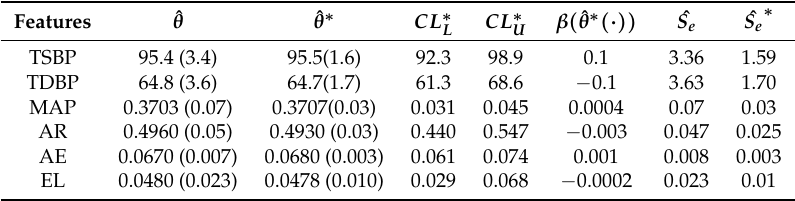
Table 3. An exemplary result (second volunteer) representing an validation between the normalized artificial features and normalized original features for consistency and convergence